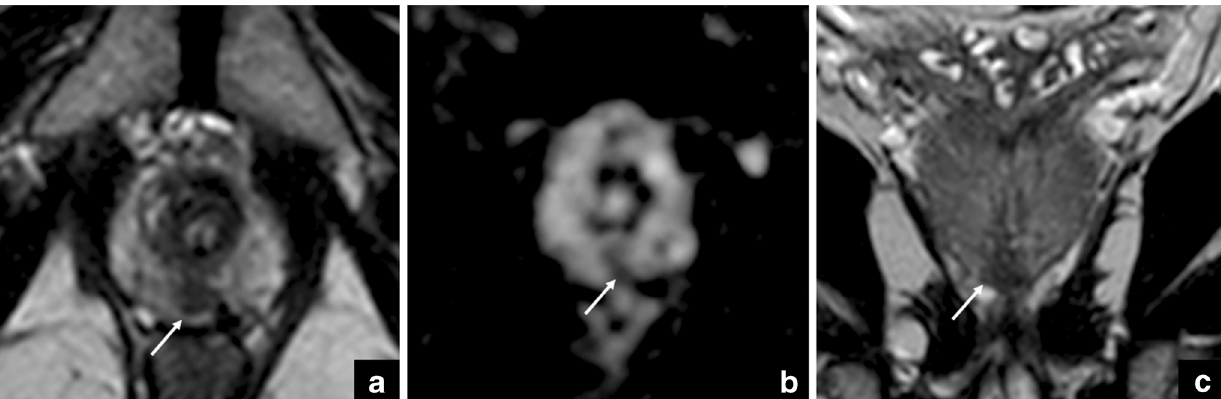
Fig. 9 The arrows show a focal area with low-signal intensity on axial ( a ) and coronal ( c ) T2-weighted imaging, and restricted diffusion on DWI ( b ) at the prostate apex. The use of the coronal plane is very important to differentiate a pitfall ( teardrop ) from prostate cancer ( cancer in pitfall